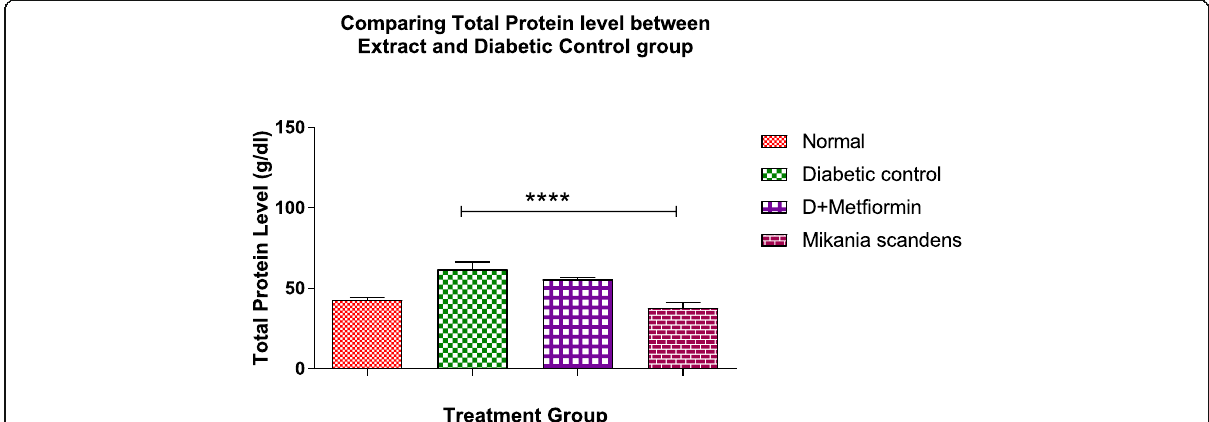
Fig. 5 Comparing total protein among diabetic control, metformin HCL and Mikania scandens animal group. Significantly different ( p < 0.05) from